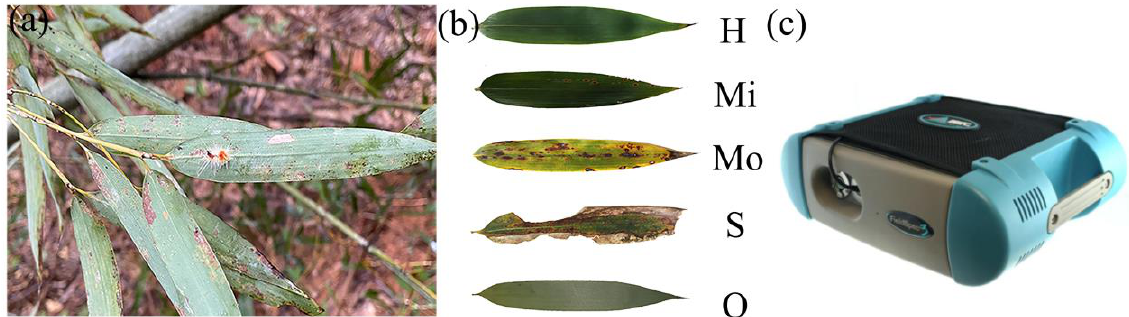
Figure 2. Sample collection and analysis: ( a ) Pantana phyllostachysae Chao larvae; ( b ) leaf samples of Moso bamboo in different states of damage; ( c ) ASD FieldSpec3 spectrometer used in the study. 0% to 5% = Healthy (H), 5% to 25% = Mildly damaged (Mi), 25% to 50% = Moderately damaged (Mo), ≥50% = Severely damaged (S), and Off -years (O).